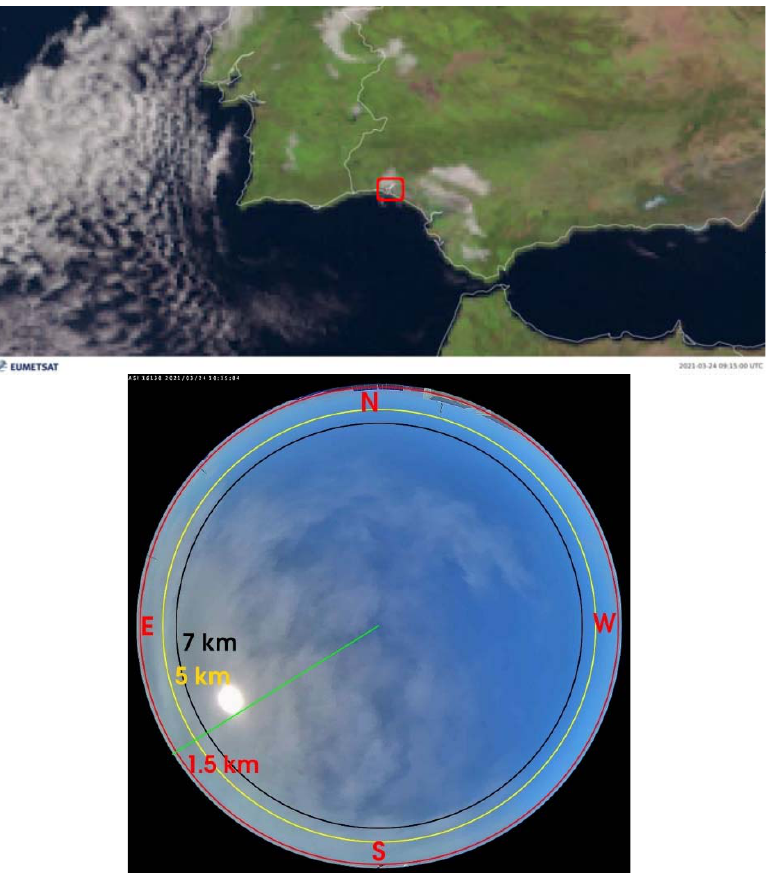
Figure 4. TOP: Satellite image showing most of southwestern Spain for 2021-03-24 at 0915 UT. The Universidad de Huelva (UHU) and El Arenosillo stations are inside the red rectangle. Some clouds are detected over both sites. BOTTOM: Sky image from the All-Sky Imager instrument located at the UHU radiometric station for the same day and instant as the satellite image above. Three circles denote three possible cloud layers (low-, medium-, and high-level clouds) at a horizontal distance of 20 km from the camera. A green line is added to mark the view direction to the El Arenosillo station.